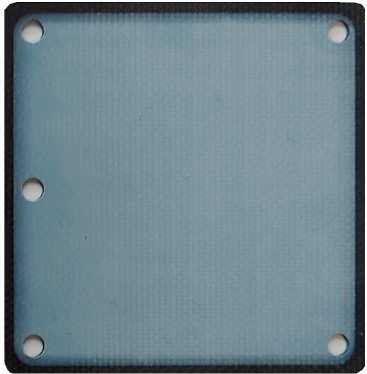
Figure 19. One of the 74 6 LiF converters (16 µm nominal layer thickness) deposited on a 1 mm thick carbon fiber substrate by means of the larger evaporator.